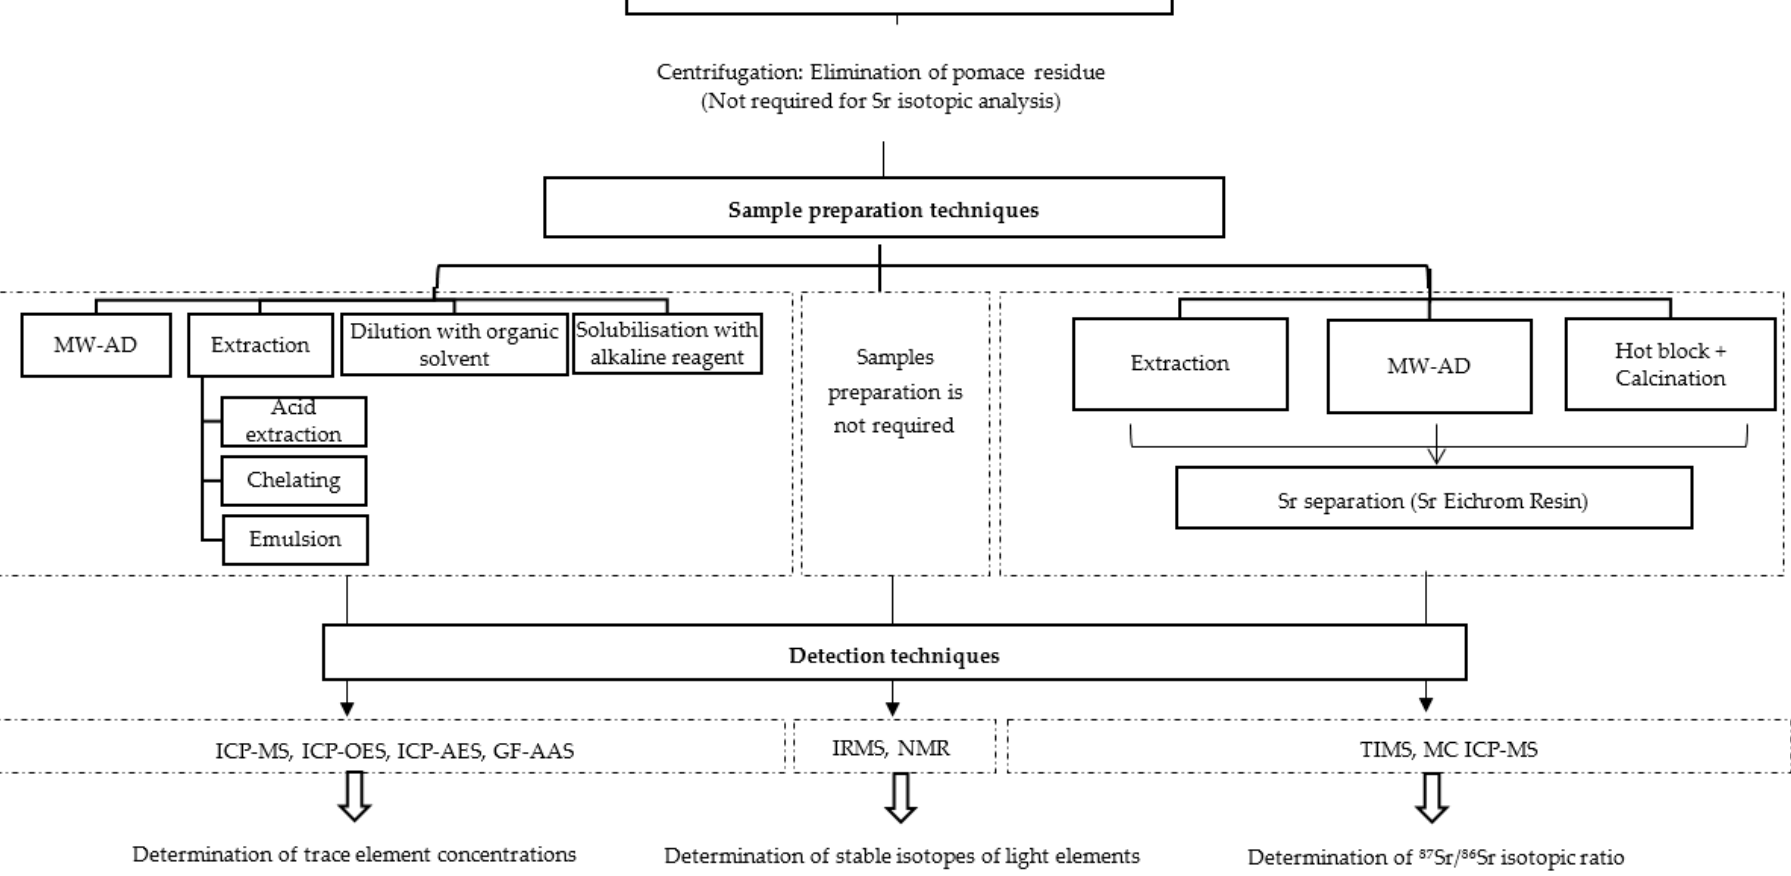
Figure 4. Analytical procedures for the analysis of trace elements, stable isotopes of light elements and Sr isotopic ratio in olive oil.